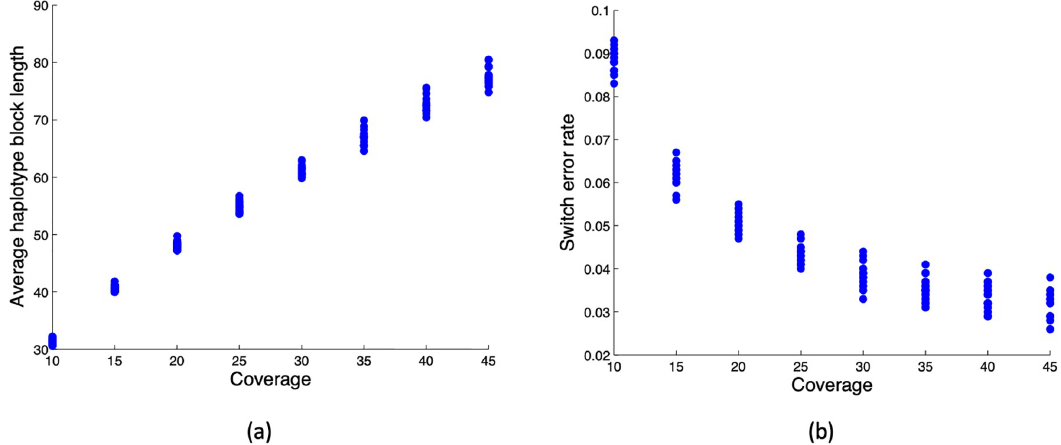
Fig 4. Accuracy of reconstructed haplotypes using HapCUT in terms of average haplotype block length and switch error rate.